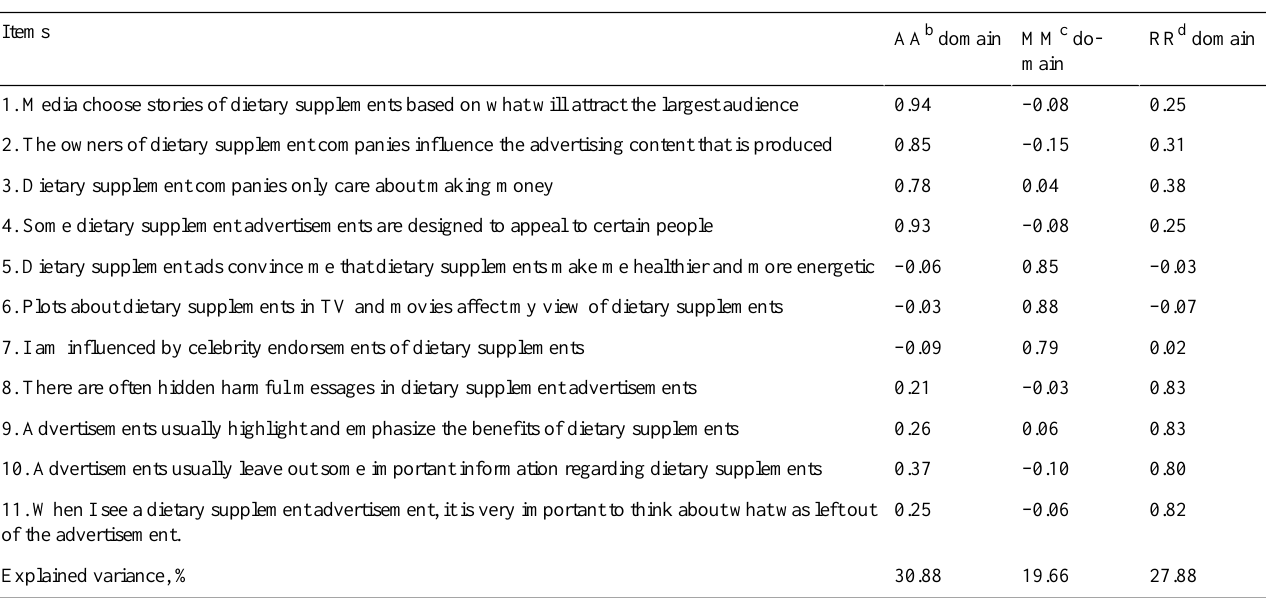
Table 1. Factor loadings for the DSMLS a